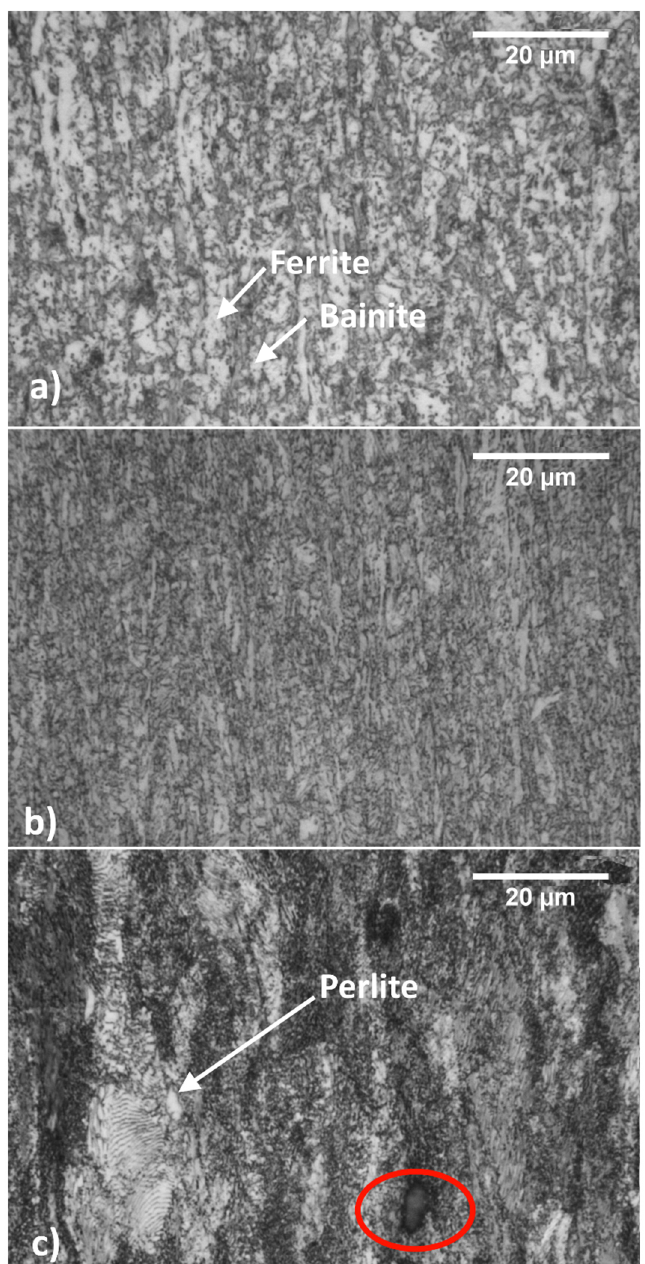
Figure 2. Steels microstructures observed with LOM: as received (hot-rolled) DP steel ( a ); 9% cold- rolled DP steel ( b ) and C67 ( c ) ferrite is less reactive toward the etching, thus remaining whiter.